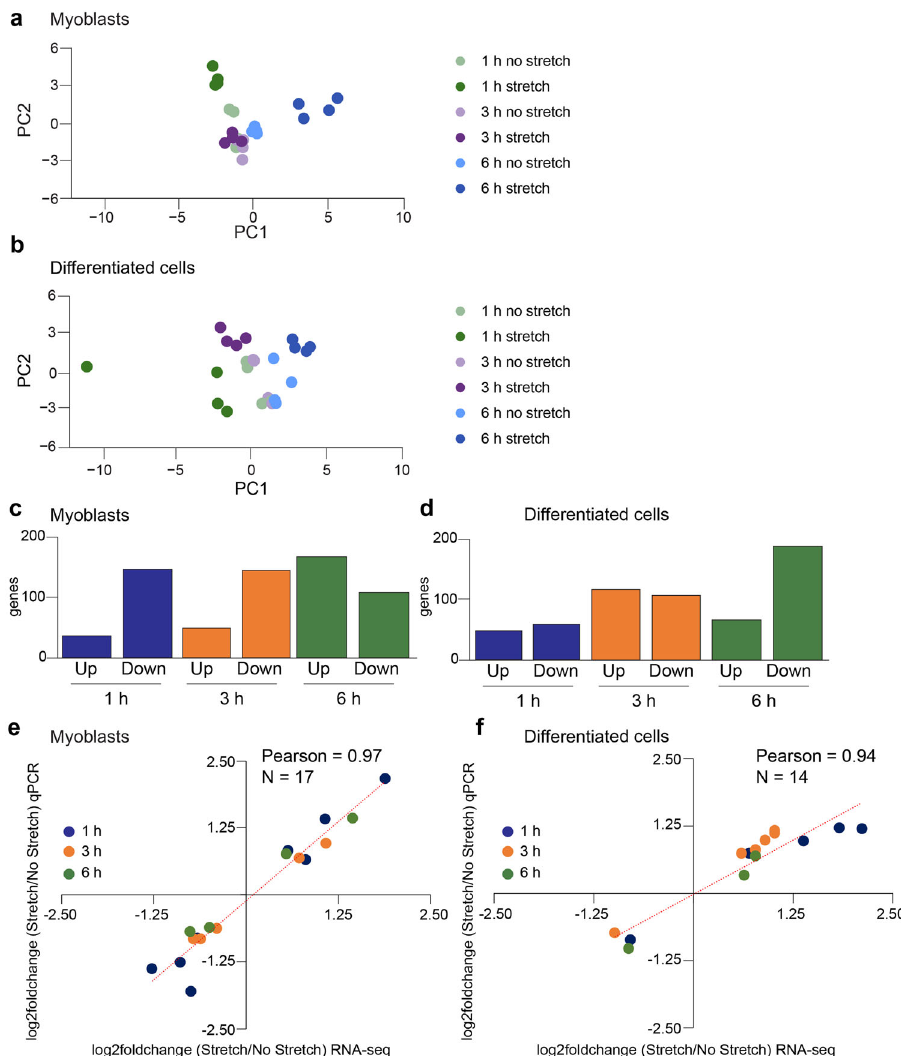
Fig. 1 Extensive gene expression changes are induced upon stretching of muscle cells. a , b Principal component analysis (PCA) plots of myoblasts and differentiated cells. c , d . Global gene expression changes after 1 h, 3 h, or 6 h stretching of myoblasts and differentiated cells. Gene expression changes were calculated by comparing stretched and non-stretched samples. Genes were considered differentially expressed when the adjusted p -value<0.05 and the fold change >1.50 (upregulated, up) or fold change < − 1.50 (downregulated, down). e , f . Correlation plot between the gene expression changes (expressed as log 2 foldchange) as measured by qPCR assays and those observed in the RNA-seq studies in myoblasts and differentiated cells. The qPCR graphs for the individual genes included in the correlation plots are shown in Supplementary Fig. 2 (myoblasts) and Supplementary Fig. 3 (differentiated